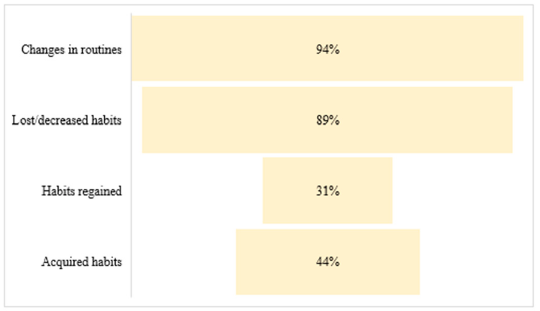
Figure 1. Changes in routines and habits during the global pandemic by COVID-19.